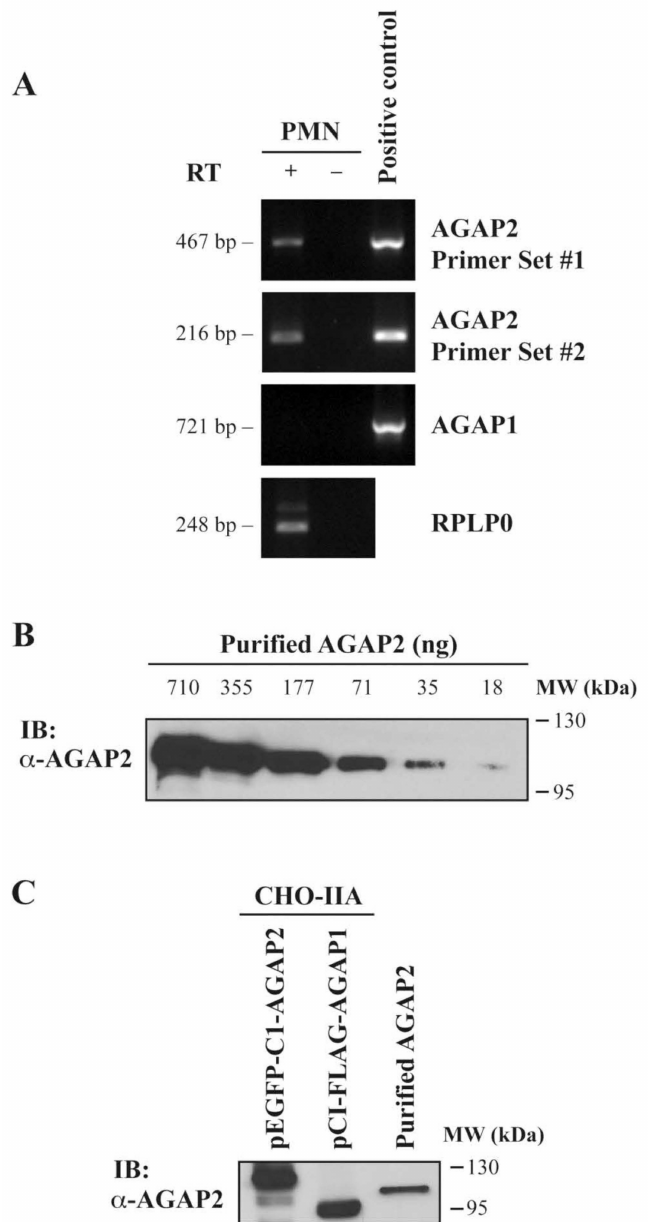
Figure 1. Expression of AGAP1 and AGAP2 mRNAs in human PMNs. ( A ) PCR analyses of AGAP2 (primer sets #1 and #2), AGAP1, and RPLPO expression, as control reaction, in PMNs. Reactions were performed on reverse transcription products (RT +), or on reverse transcription reactions performed without reverse transcriptase (RT − ) as genomic DNA control. pEGFP-C1AGAP2 and pCI-FLAG- AGAP1 templates were used as positive controls. ( B ) Sensitivity of the polyclonal anti-AGAP2 antibody was determined using decreasing amounts of purified His6tagged AGAP2. ( C ) CHO-IIA cells were transfected with pEGFP-C1-AGAP2 or pCI-FLAGAGAP1 and specificity of the anti-AGAP2 antibody (1/5000) was examined by Western blotting. Purified His6-tagged AGAP2 was used as a